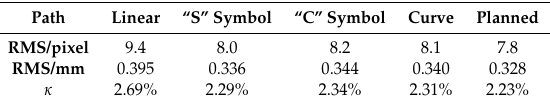
Table 2. Root mean square (RMS) error of the distance.